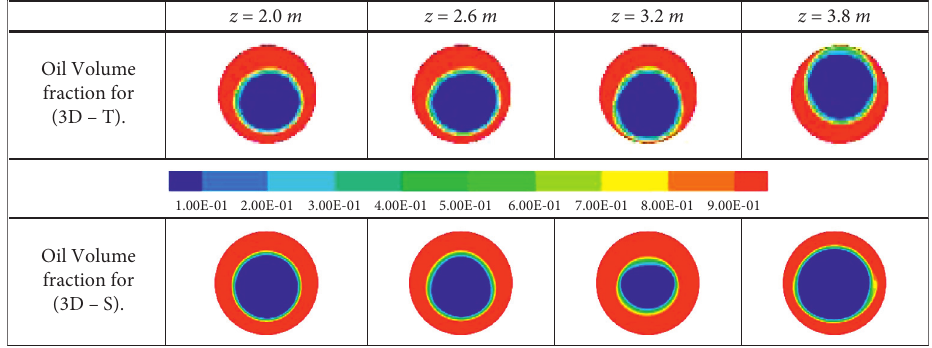
Figure 6: Comparison of the oil volume fraction in the xy -plane for 3D-T and 3D-S configurations.